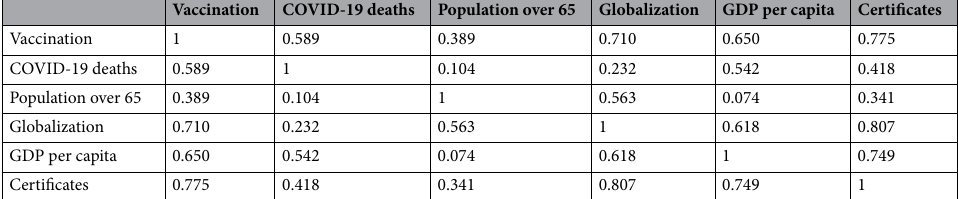
Table 2. Correlation test for analyzed variables.